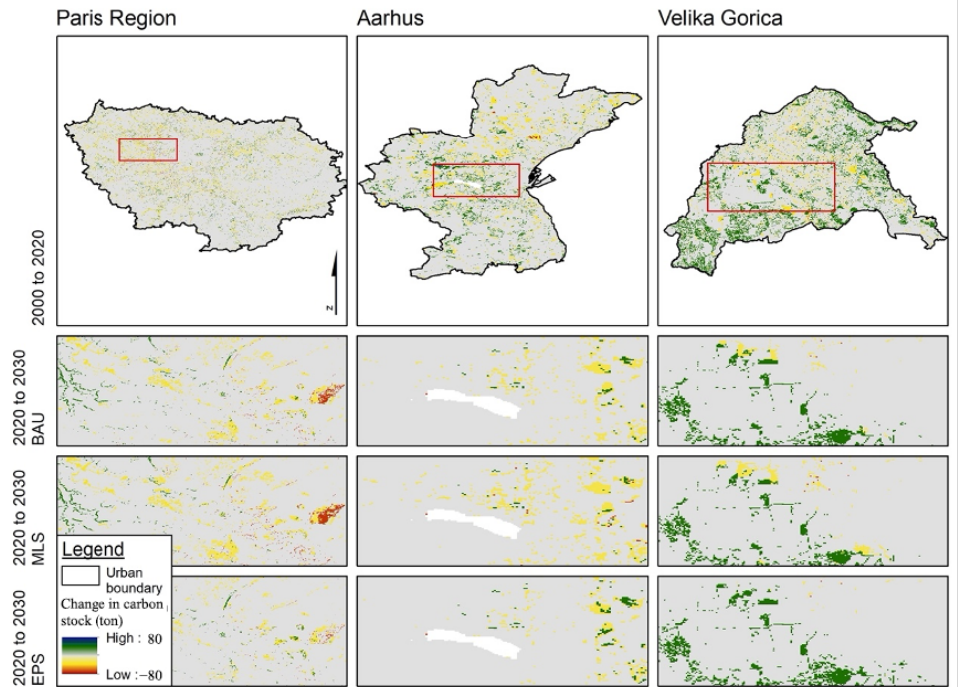
Figure A4. Changes in carbon stock in Paris region, Aarhus, and Velika Gorica for 2000 to 2020 and 2020 to 2030 under three different scenarios (BAU, MLS, and EPS).